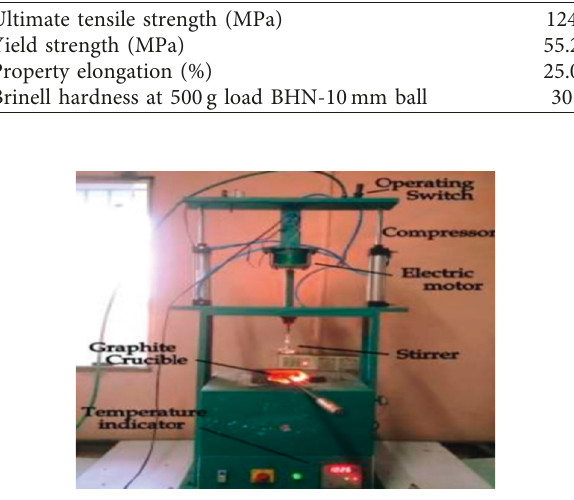
Figure 1: Stir casting